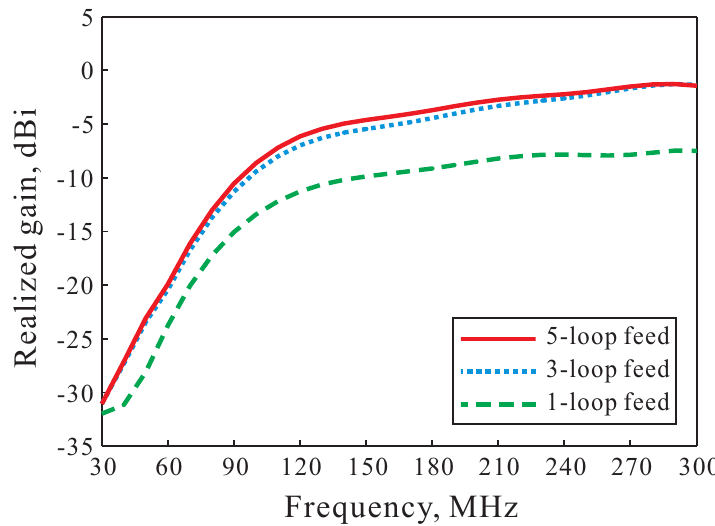
Figure 4. Simulated realized vertical-polarization gains at the main beam direction ( + z ) of the ferrite dipole antenna with different numbers of loop